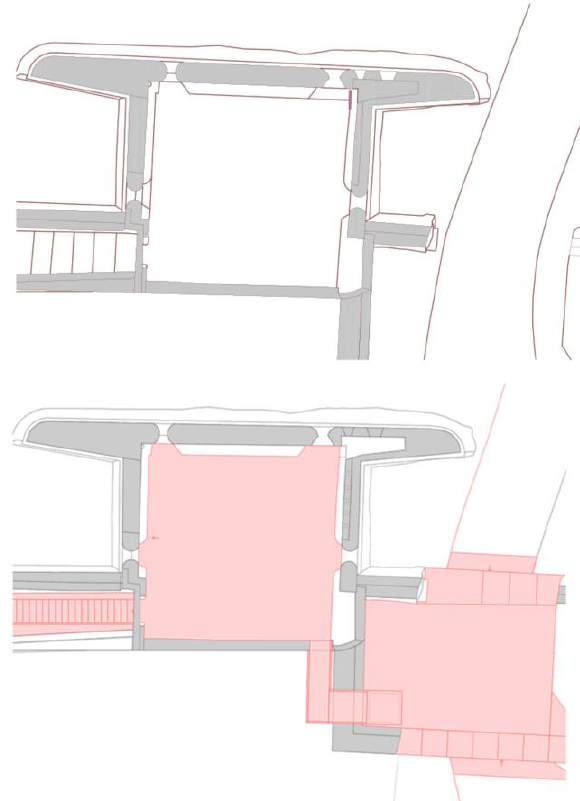
Figure 7. Top view CAD drawings of “Baluarte da Porta dos quartos”; survey (top) and design intentions (bottom)